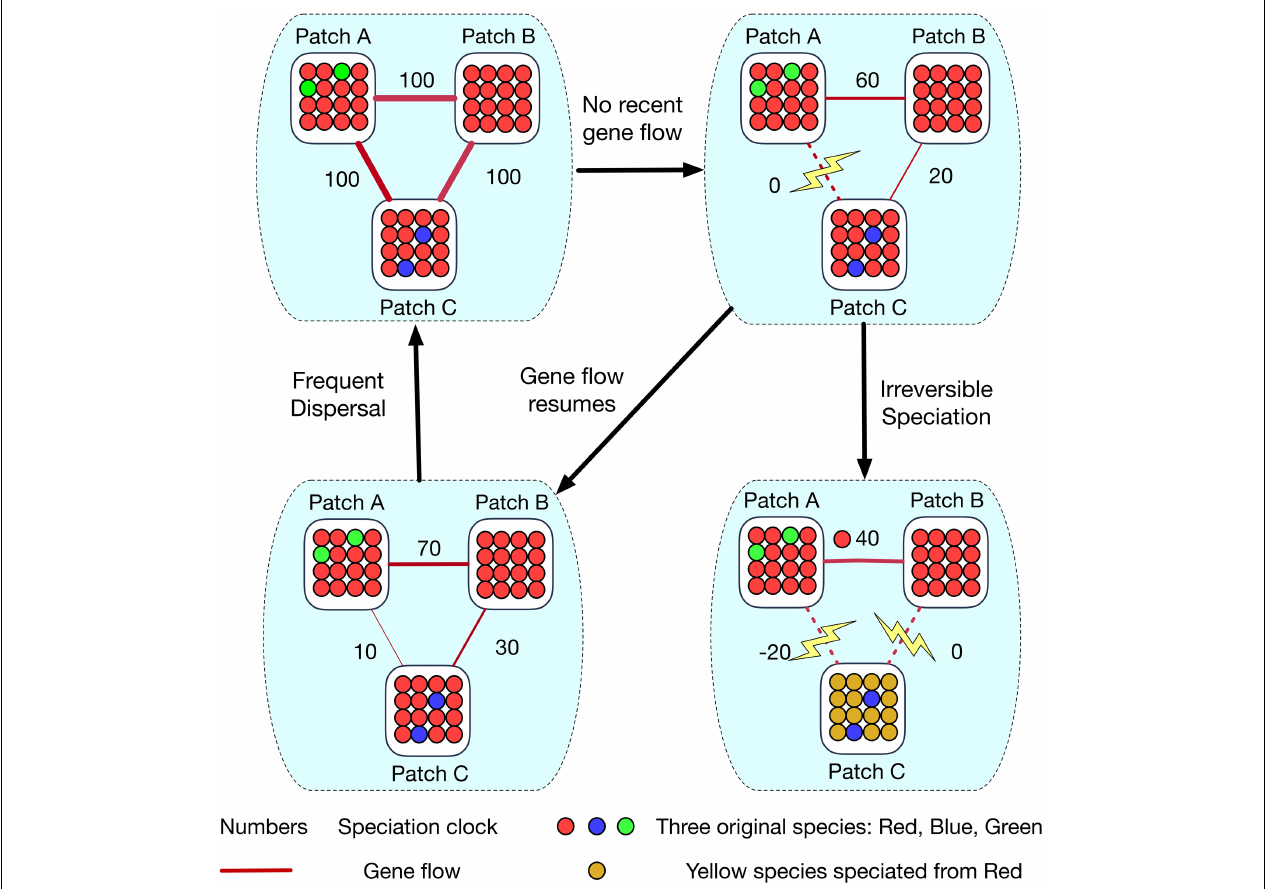
FIGURE 3 | A schematic diagram showing how allopatric speciation (cladogenesis) happens in a community network of patches. Assume there are 3 patches (A, B, and C) fully connected to each other. In this example, the red species has spread to all 3 patches, so gene flow occurs between all these patches and links them as a gene flow network. The gene flow strength is shown by the width of the red line. The ‘clock’ for speciation is initially equal to τ = 100. When the conspecific link between red species population in patch A and C has been eroded by lack of gene flow, these populations remain conspecific because they are connected via patch B: red individuals in patch A and B are conspecific and the same is true for red individuals in patch C and B - so patch A and C must also remain conspecific. Irreversible speciation finally occurs when the conspecific link between patch C and B is cut, and the conspecific link between patch A and C remains unconnected so that the red population in patch C can now speciate from its relatives in patches A and B to from a new yellow species by allopatric speciation. In the scenario where gene flow resumes, the conspecific link between patch A and C has been revived, so the red species in all three local patches is back to being a complete gene flow